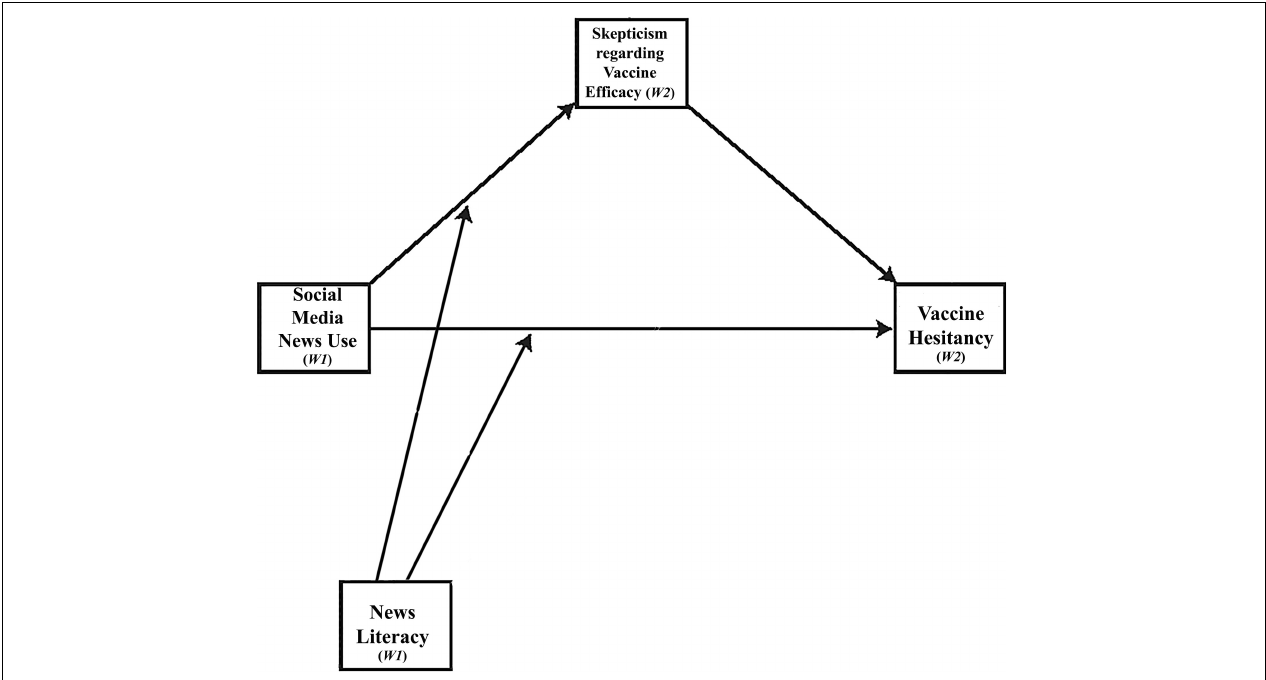
FIGURE 1 | Conceptual